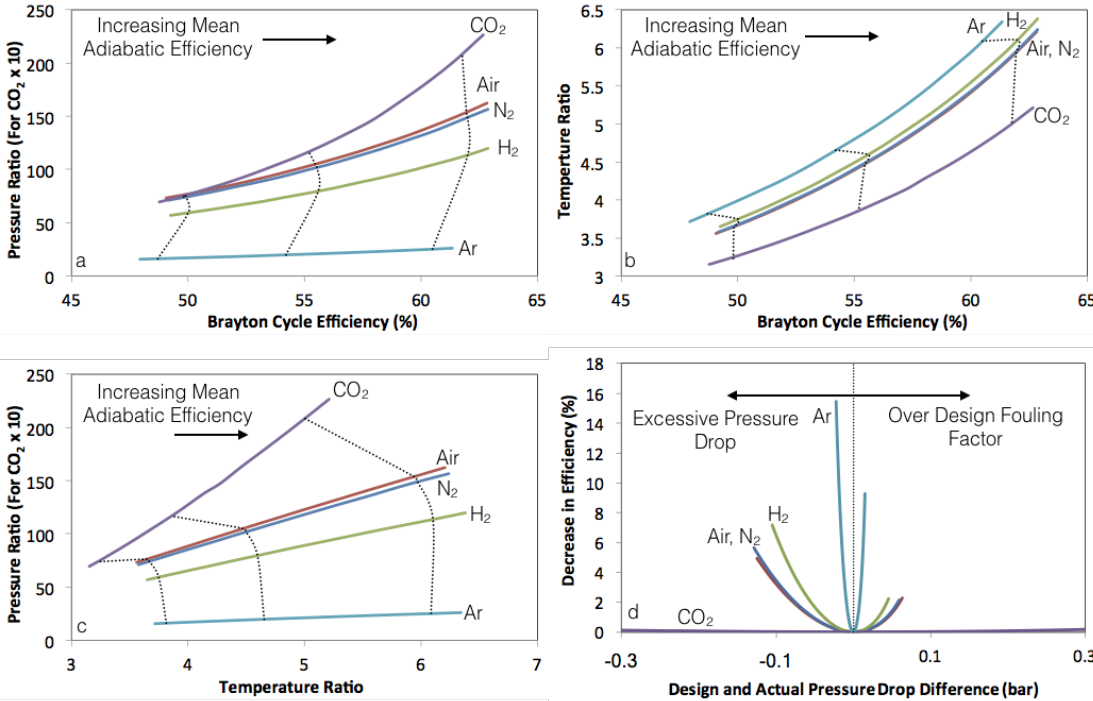
Figure 3. Light blue—Ar, green—H 2 , blue—N 2 , red—Air, purple—CO 2 , ( a ) optimized pressure ratio versus simple cycle e ffi ciency for various adiabatic e ffi ciencies. Dotted lines represent the two limits and the mean operating conditions. Pressure ratio = turbine inlet Pressure / 118 kPa. ( b ) Optimized temperature ratio versus simple cycle e ffi ciency for various adiabatic e ffi ciencies. Dotted lines represent the two limits and the mean operating conditions. Temperature ratio = 1435 ◦ C / Exhaust Temperature. ( c ) Pressure ratio versus temperature ratio. ( d ) Di ff erential of ‘a’, dotted line presents the zero x–axis.